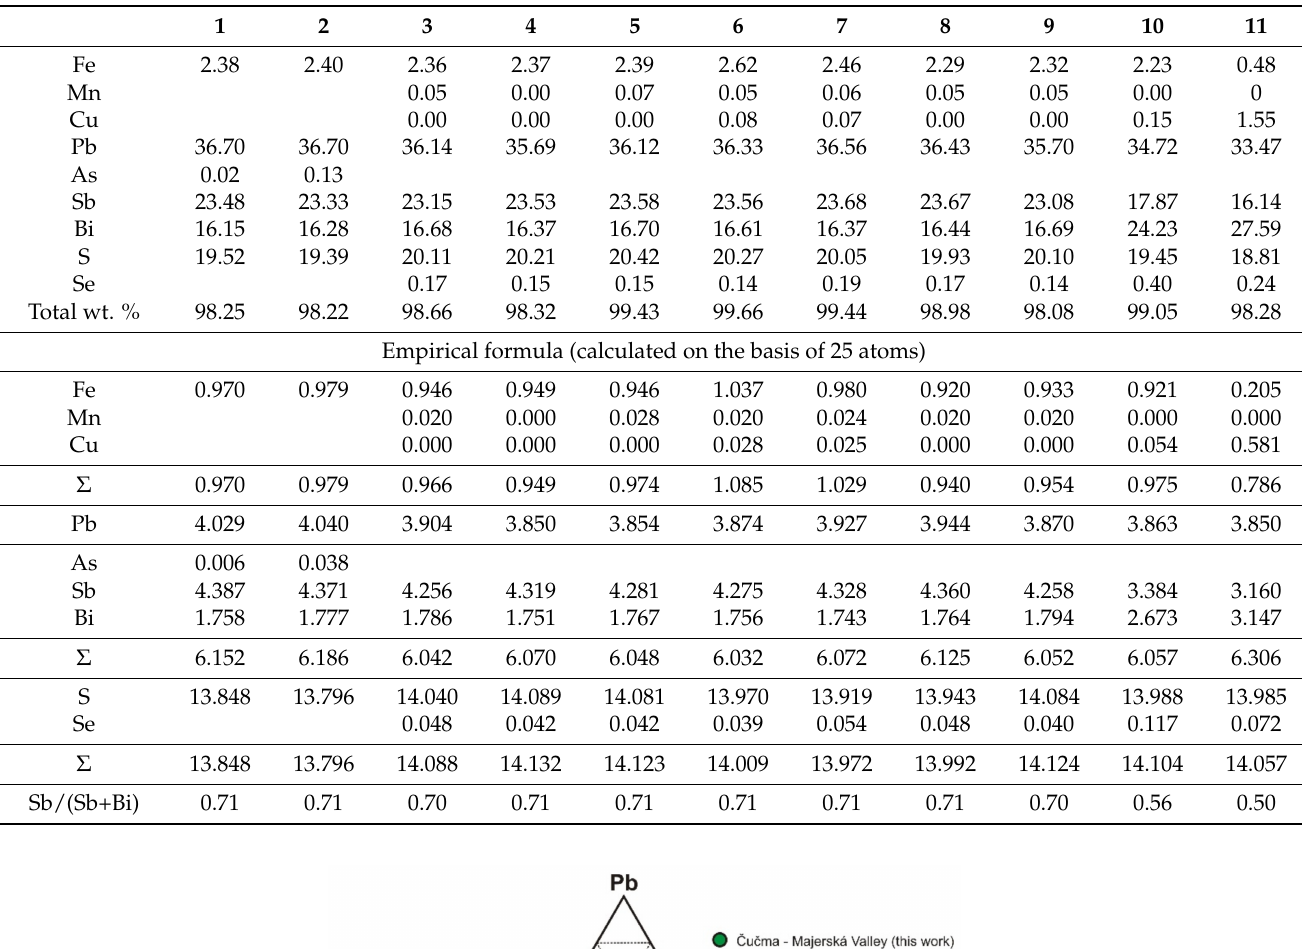
Table 12. Chemical composition of jamesonite from ˇCuˇcma (Majersk á valley).